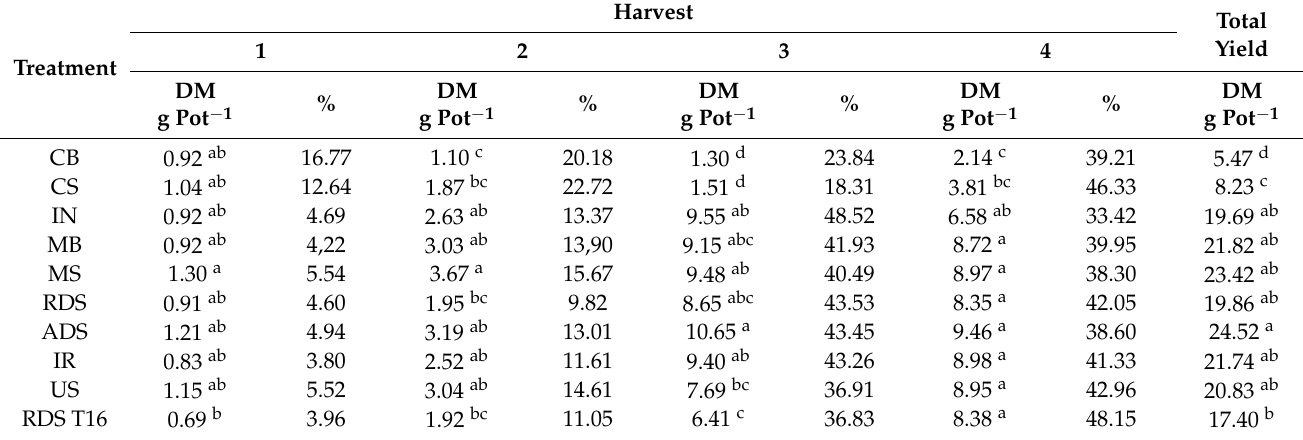
Table 1. Ryegrass aboveground DM yield and as a percentage of total yield (%) obtained at each harvest. Values presented are arithmetic means of three replicates. For each parameter, values followed by different letters in the same column, are significantly different based on the Tukey test ( p <